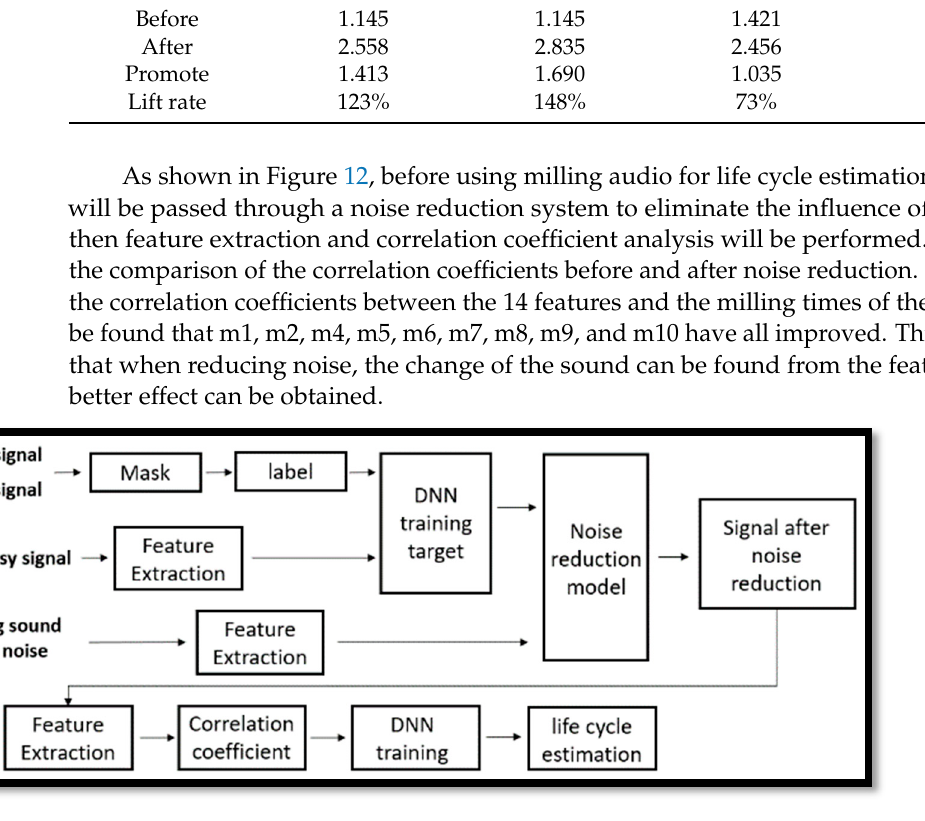
Figure 12. Flow chart of life cycle estimation system after noise reduction. Table 11. Comparison of correlation coefficients between MFCC and milling times after noise reduction.